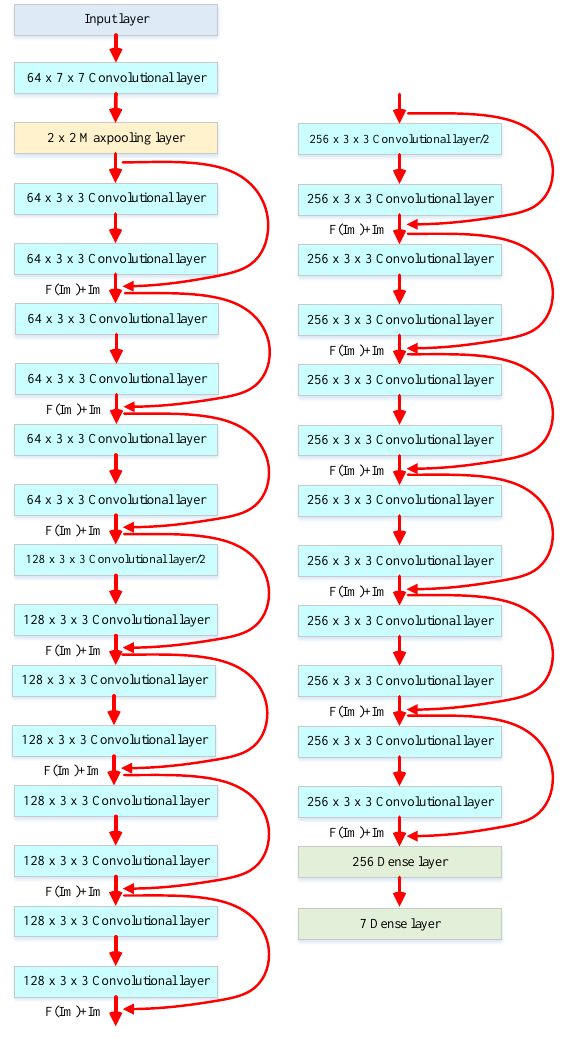
Figure 3. The structure of ResNet-based CNN